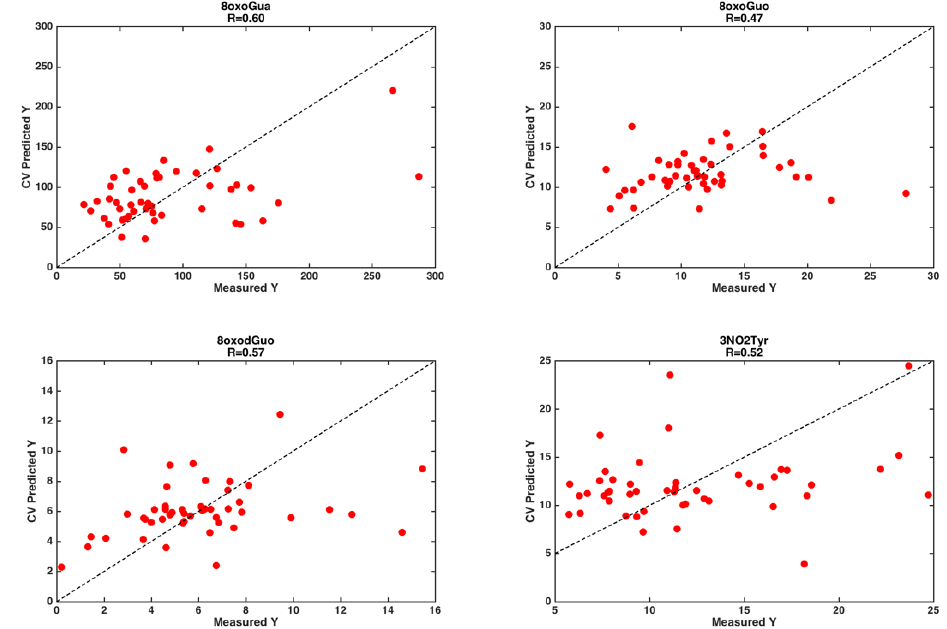
Figure 4. Results of multiple linear regression (MLR) modeling between individual oxidative stress biomarkers and the set of exposure biomarkers for the selected subset of 47 individuals with the highest level of exposure: plots of cross-validated predictions vs. observed values.